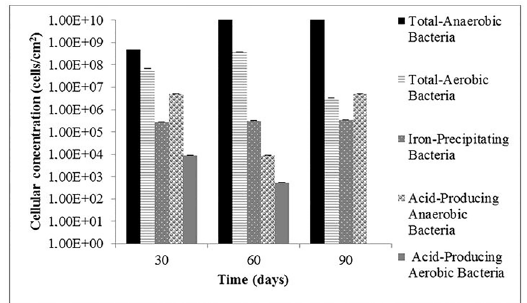
Figure 3. Quantification of sessile microorganisms in the